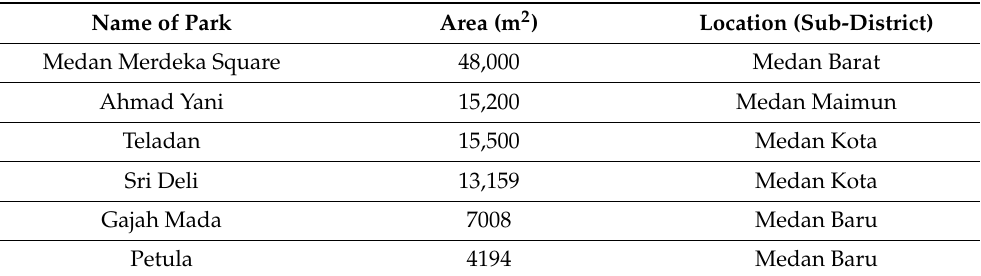
Table 1. Description of